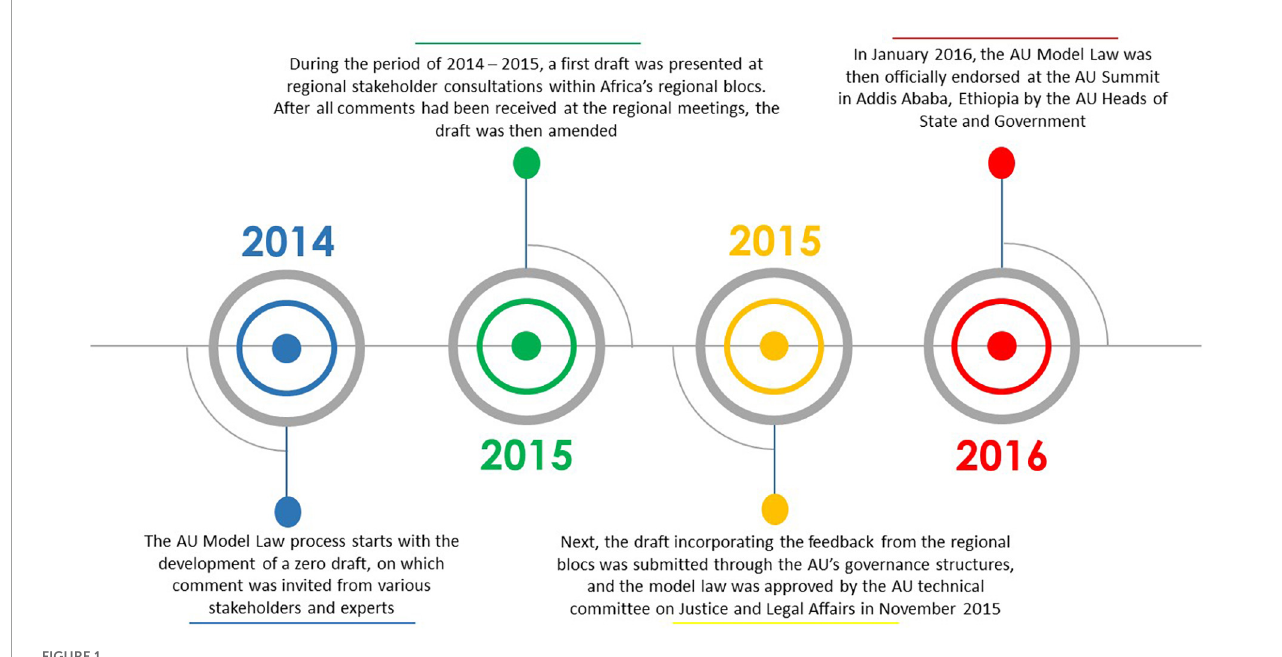
FIGURE1 Timeline of the AU Model Law development